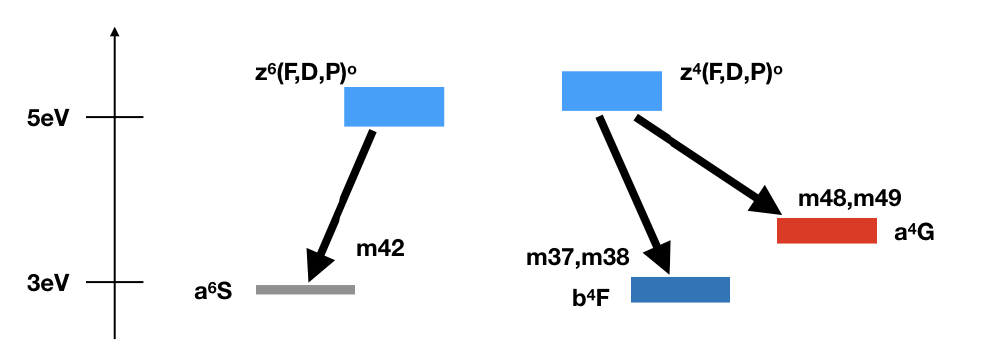
Figure 2. Highly simplified Grotrian diagram of the energy levels leading to the strongest Fe II transitions in the spectral range 4400 Å–5600